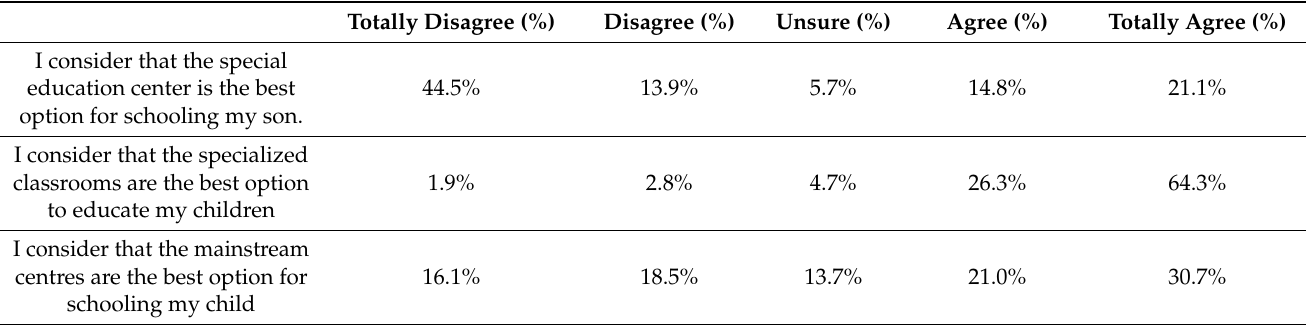
Table 4. Descriptive statistics in relation to the type of schooling preferred by families.